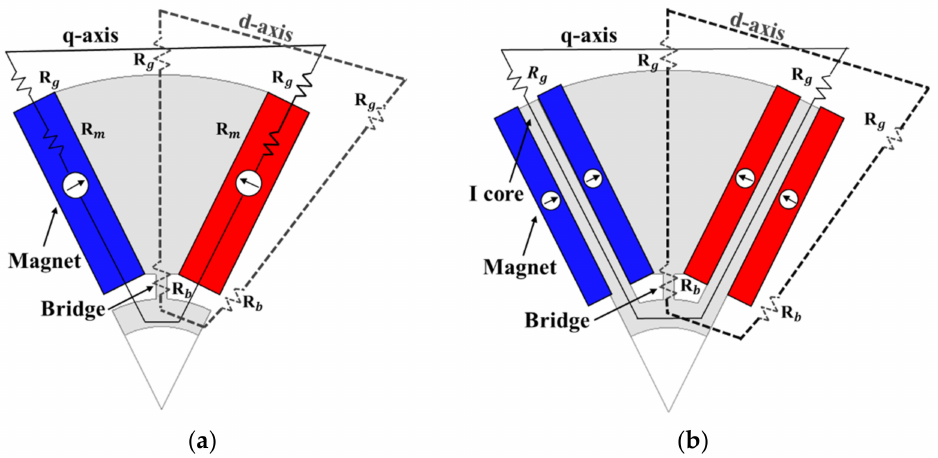
Figure 3. MEC model, ( a ) spoke-type PMSM ( b ) I spoke-type